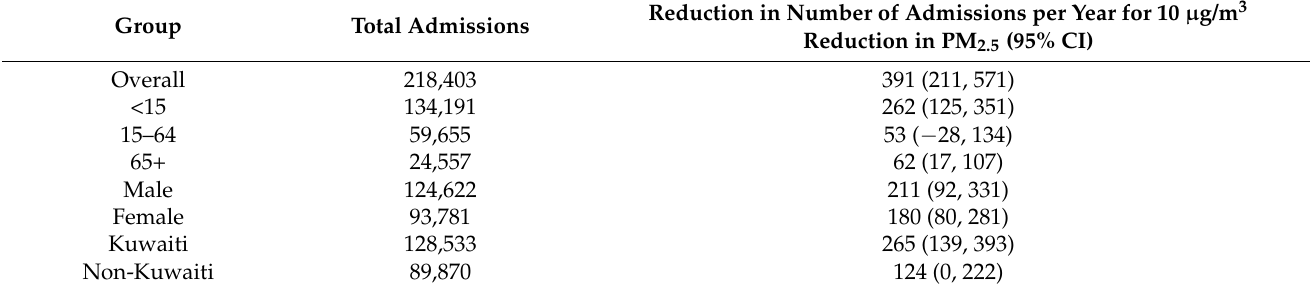
Table 5. Respiratory admissions potentially averted for 10 µ g/m 3 reduction in PM 2.5 exposure in